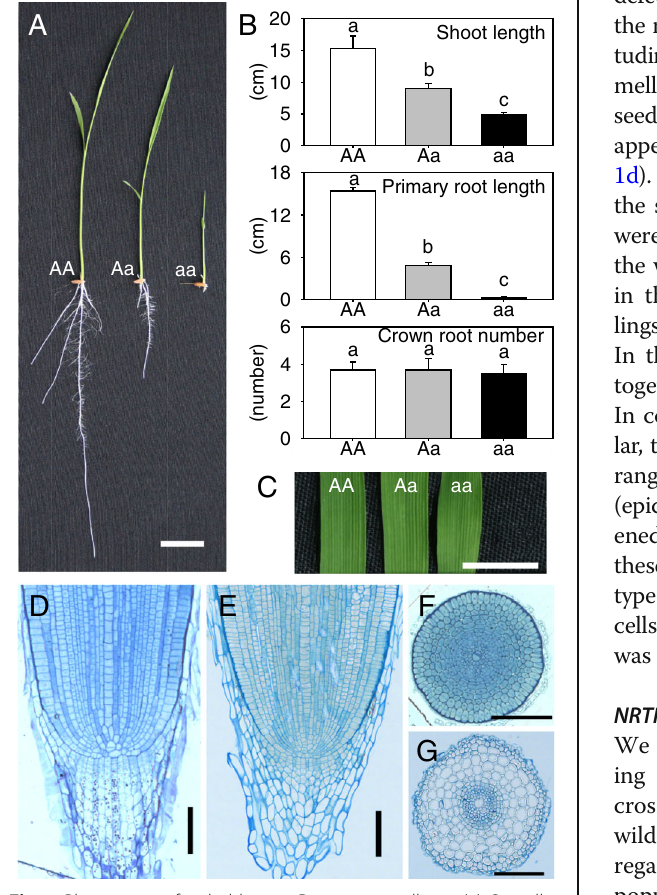
Fig. 1 Phenotypes of 7-d-old nrtp1-D mutant seedlings. ( a ) Overall comparison of phenotypes between wild type and nrtp1-D mutant seedlings. AA, wild-type ‘ Kasalath ’ plants; Aa, nrtp1-D heterozygous plants; aa, nrtp1-D homozygous plants. Bar = 2 cm. ( b ) Shoot length, primary root length and crown root number of nrtp1-D mutant seedlings. Samples with different letters are significantly different ( P < 0.01; Tukey ’ s test). Values are mean ± SD of three biological replicates. White, AA; grey, Aa; black, aa. ( c ) Comparison of leaves among AA, Aa and aa. Bar = 0.5 cm. ( d ) Longitudinal section of wild-type root tip. ( e ) Longitudinal section of homozygous mutant root tip. ( f ) Transverse section of wild-type root tip. ( g ) Cross section of homozygous mutant root tip. Bars = 200 μ